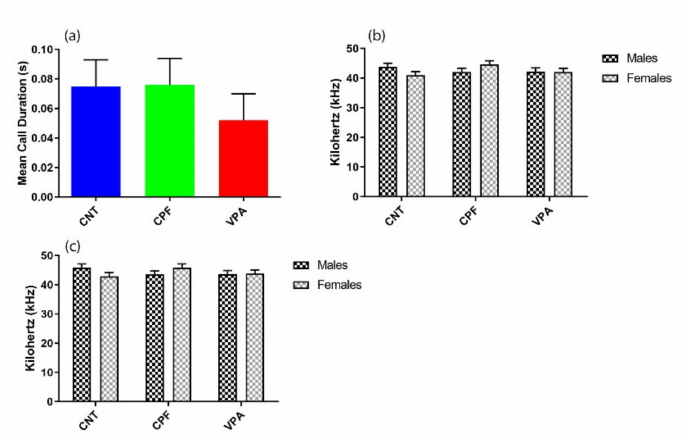
Figure 4. Characteristics of the USVs (n = 42): ( a ) There were no significant di ff erences in Mean Call Duration between the treatment groups, although there is a tendency for the VPA (n = 14) group to emit shorter calls than the other two groups (CNT n = 14; CPF n = 14). Moreover, the groups did not di ff er in terms of either Principal Peak Frequency ( b ) or High Peak Frequency ( c